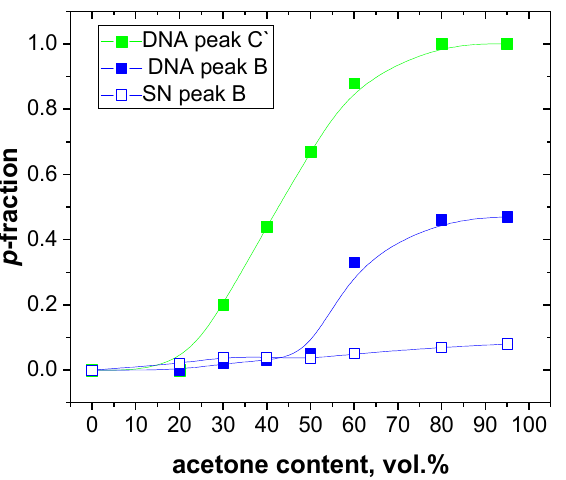
Figure 5. Dependence of p -fraction on the acetone content for the PDEAAm CH 2 signal in the DN-DA hydrogel and the PAAm CH signal in the DN-DA and SN-D hydrogels (measured at 25 °C).